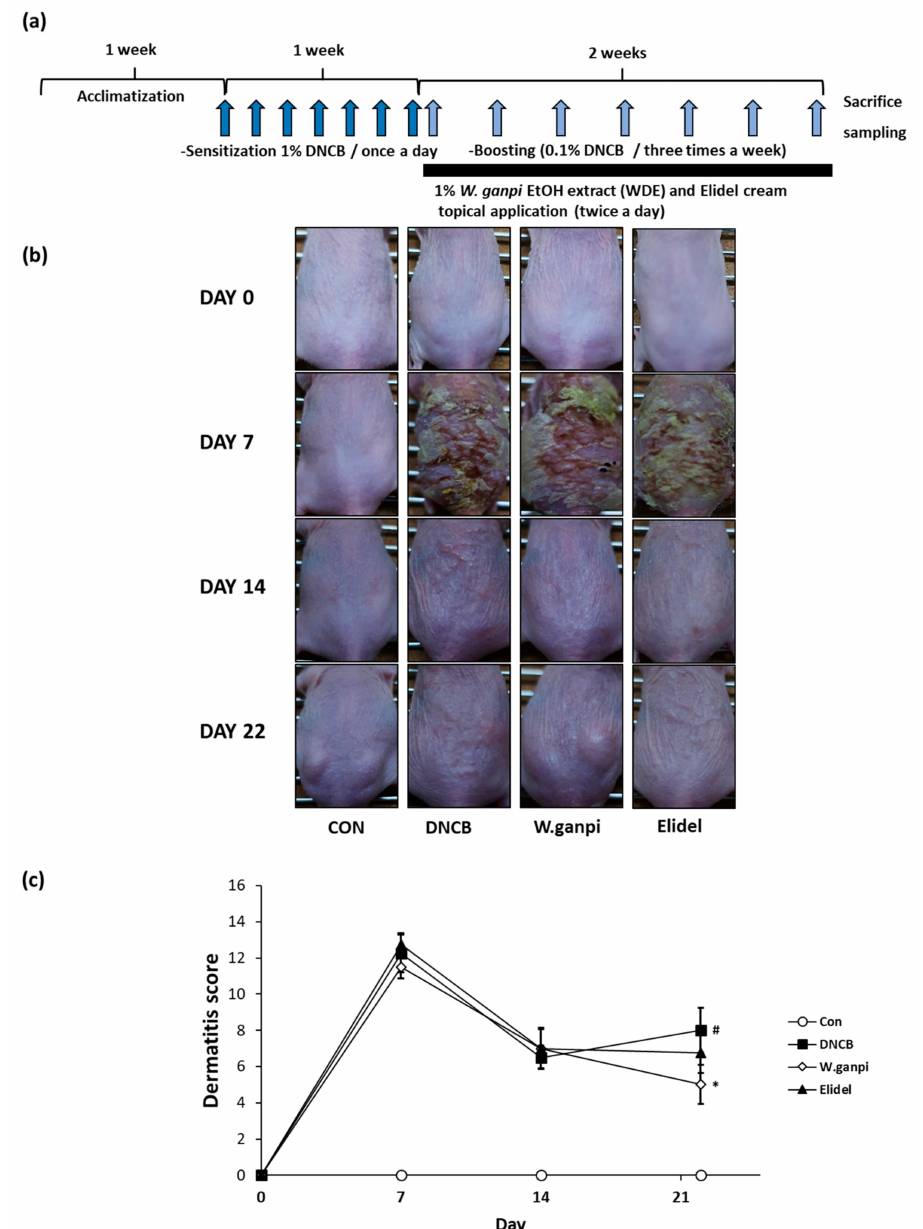
Figure 1. Effects of W. ganpi EtOH extract (WGE) on the development of Atopic dermatitis (AD)-like symptoms induced by 2,4-dinitrochlorobenzene (DNCB) in the dorsal skin of the SKH-1 hairless mice. ( a ) Summarized diagram of the experiment schedule; ( b ) Clinical change of the AD-like skin lesion; ( c ) Dermatitis score. CON: control group, DNCB: DNCB-treated group, W. ganpi : DNCB and 1% W. ganpi EtOH extract-treated group, Elidel: DNCB and Elidel cream treated group. # p < 0.05 vs. the CON group; * p < 0.05 vs. the DNCB